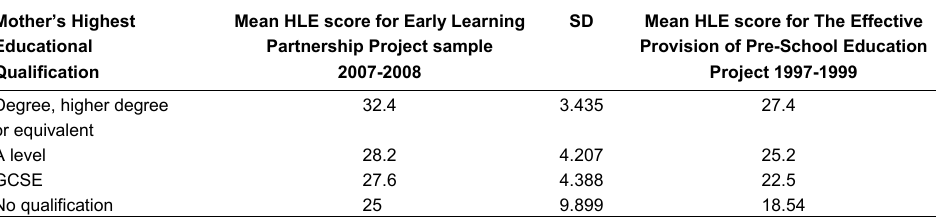
Table 5: Mean scores on the Home Learning Environment: comparing ELPP to